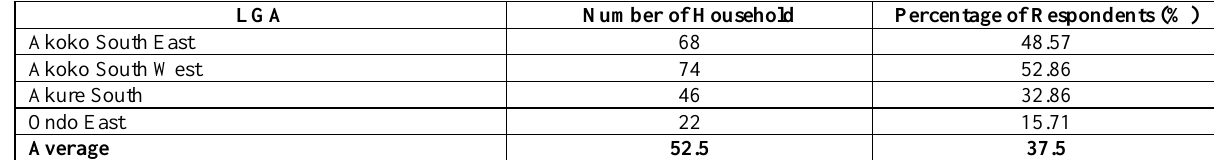
Table 2. Meter Coverage before the Introduction of Pre-Paid Meter